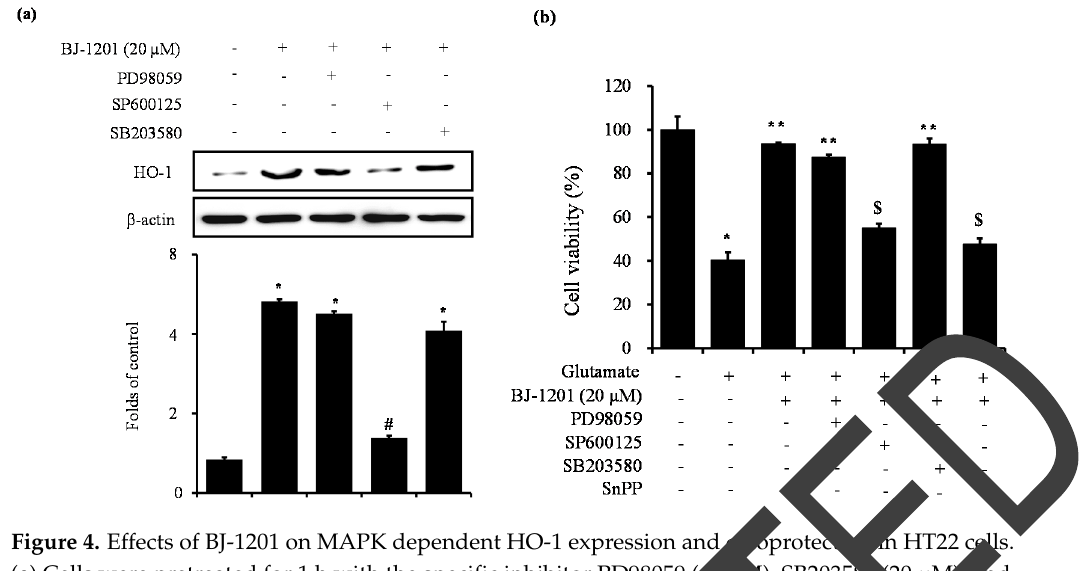
Figure 4. Effects of BJ-1201 on MAPK dependent HO-1 expression and cytoprotection in HT22 cells. ( a ) Cells were pretreated for 1 h with the specific inhibitor PD98059 (40 μ M), SB203580 (20 μ M), and SP600125 (25 μ M), and then treated with 20 μ M BJ-1201 for 18 h. Western blotting was then performed with HO-1 antibody; ( b ) Cells were treated with 20 μ M BJ-1201 in the presence or absence of each specific inhibitors and SnPP (50 μ M) for 12 h were exposed to 5 mM glutamate for 12 h. Data represent the mean ± S.D. of three independent experiments. * p < 0.05 compared with control group. # p < 0.05 compared with BJ-1201. ** p < 0.05 compared with glutamate (10 mM). $ p < 0.05 compared with glutamate + BJ-1201.